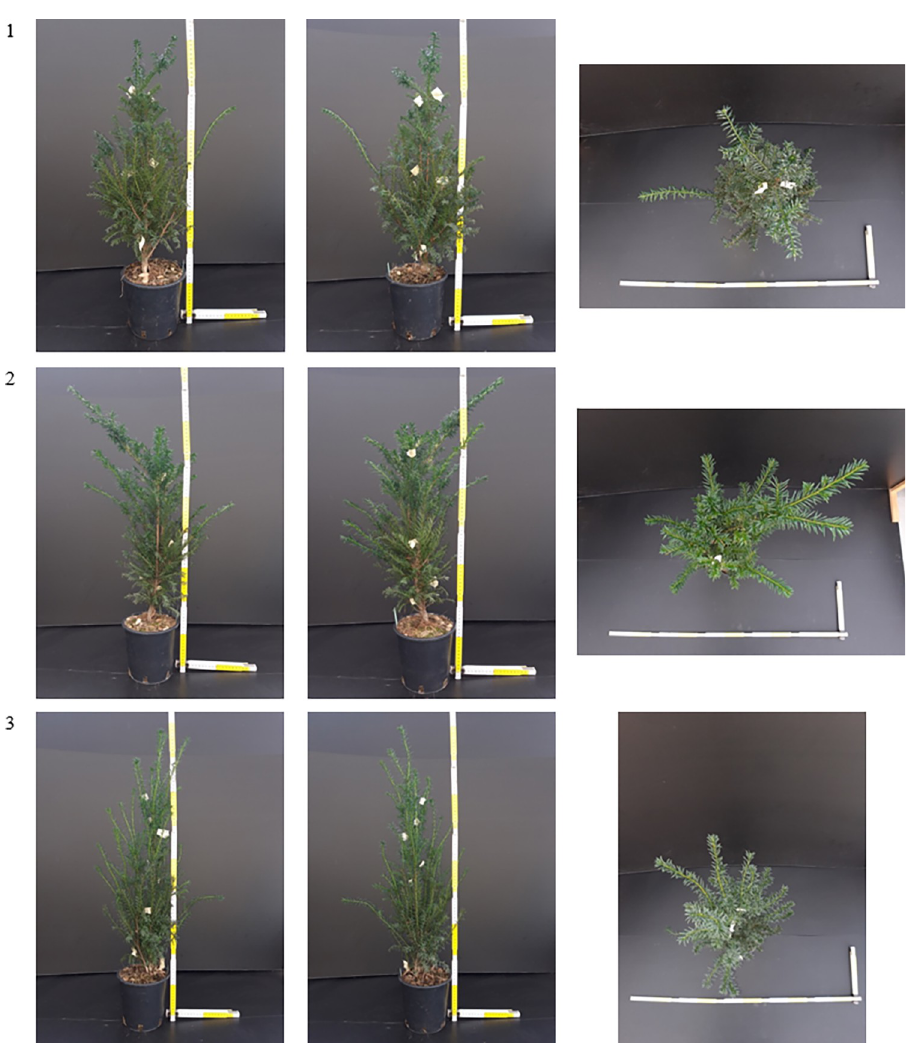
Fig 4. Plants’ views. Front, rear and above views of a plant from Control (1), R/B/Fr 100 (2), and B 100 (3) treatments on 9 December 2019.